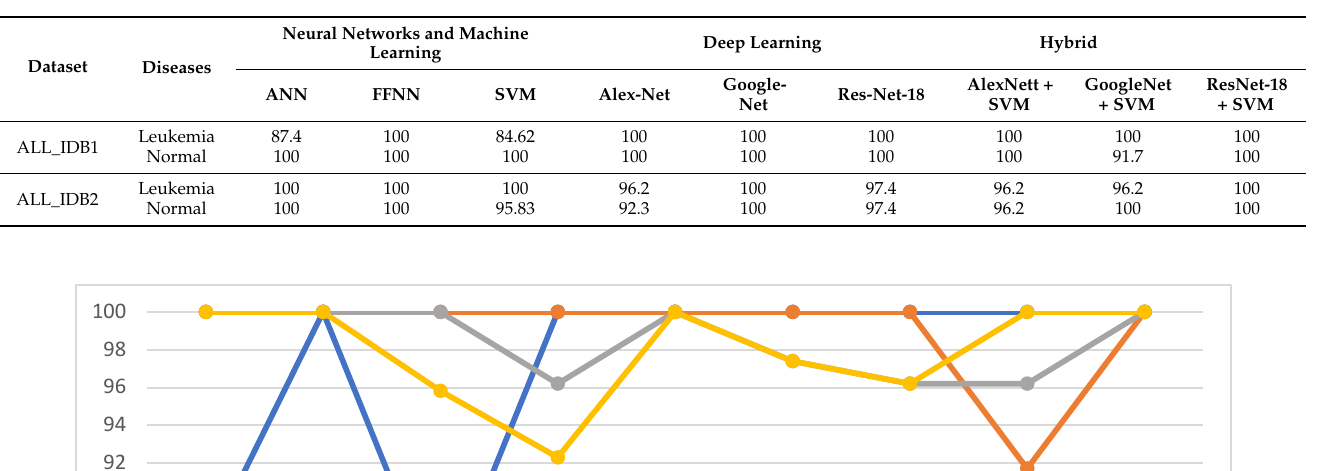
Table 7. The accuracy reached by proposed system in the diagnosis each class.